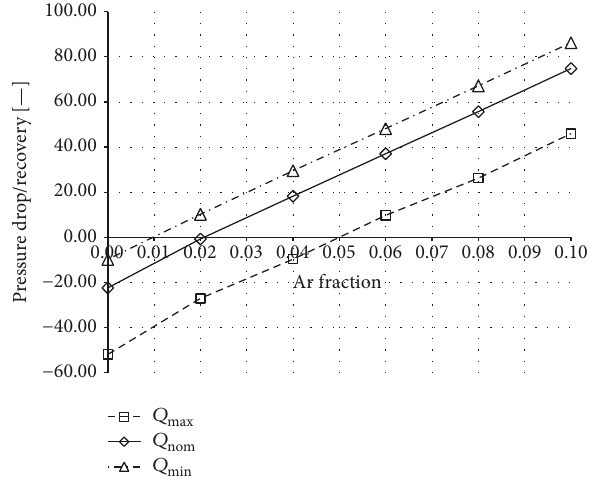
Figure 20: Pressure drop across Venturi meter for different mass flow rate and Ar volume fractions.